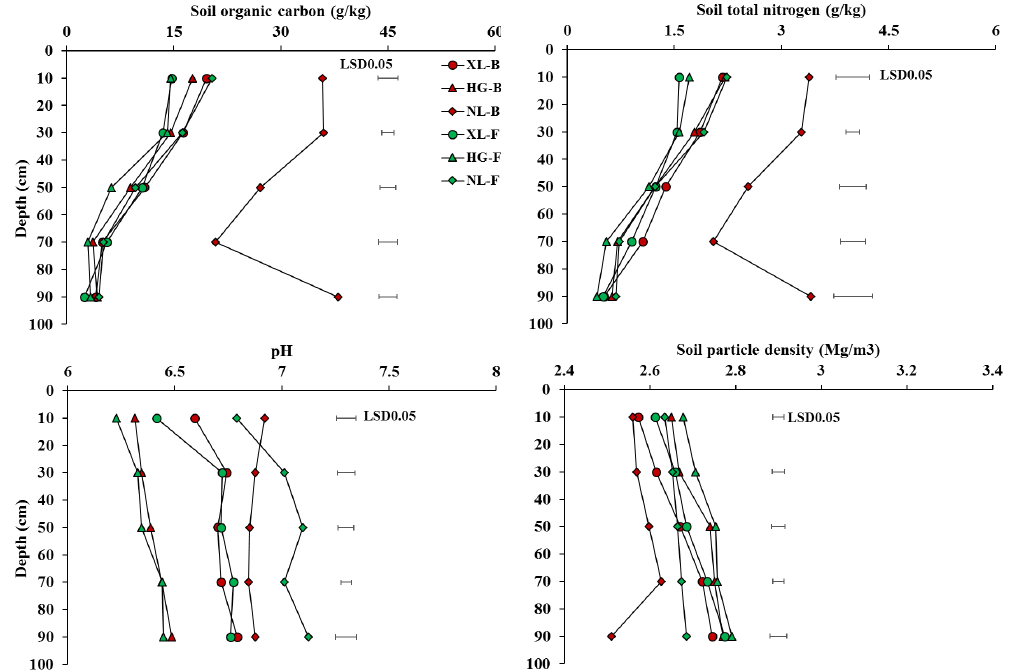
Figure 3. The distribution of soil physicochemical properties in profiles at different land use sites. For abbreviations, see Fig. 2.